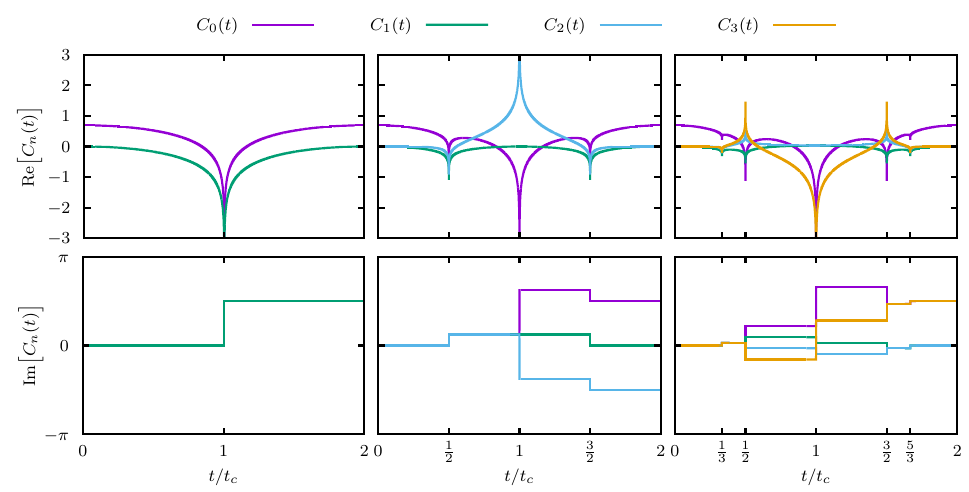
Figure 9: Time evolution of the couplings of the effective Hamilton function H ( (cid:126) s , t ) for the Loschmidt amplitude in one, two, and three